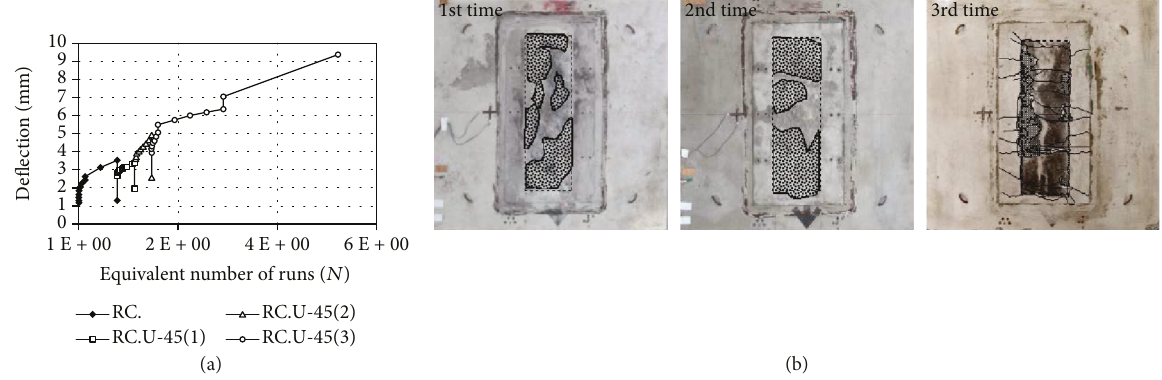
Figure 8: RC-UF-45. (a) Relationship between de fl ection and number of equivalent cycles. (b) Condition of damage caused on the upper